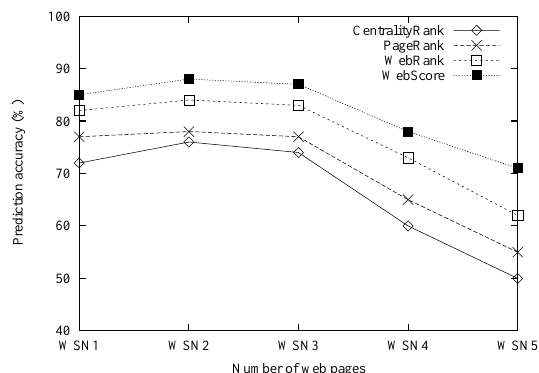
Fig. 3. Scoring accuracy comparison among algorithms.